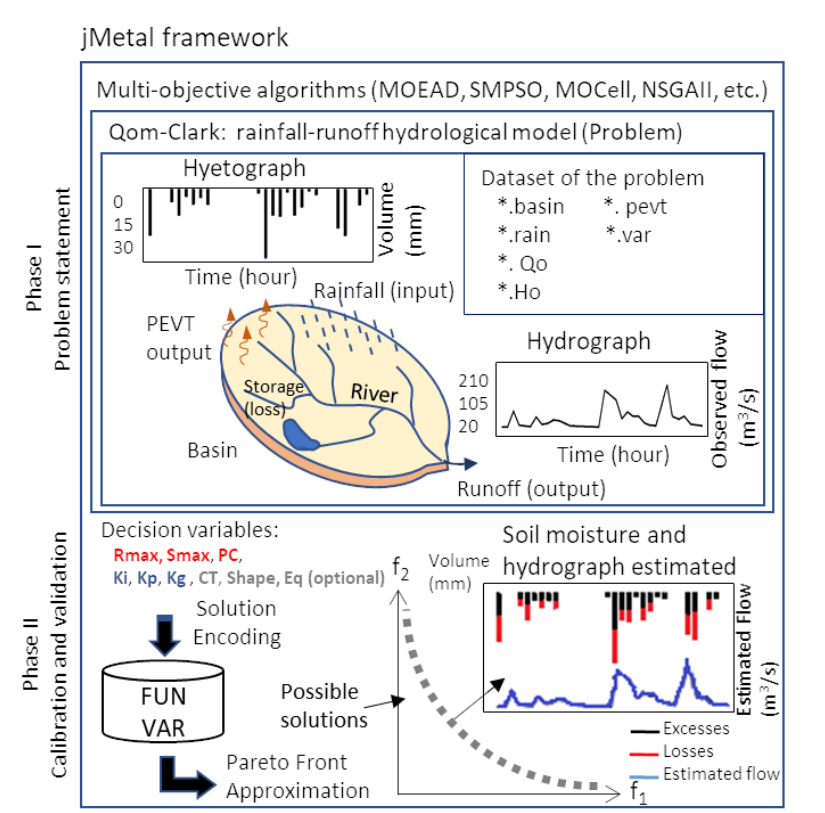
Figure 3. Scheme of the optimization process using